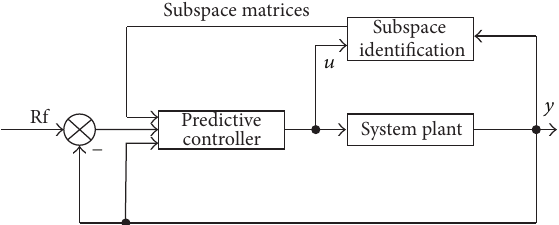
Figure 1: The structure of closed-loop data-driven predictive